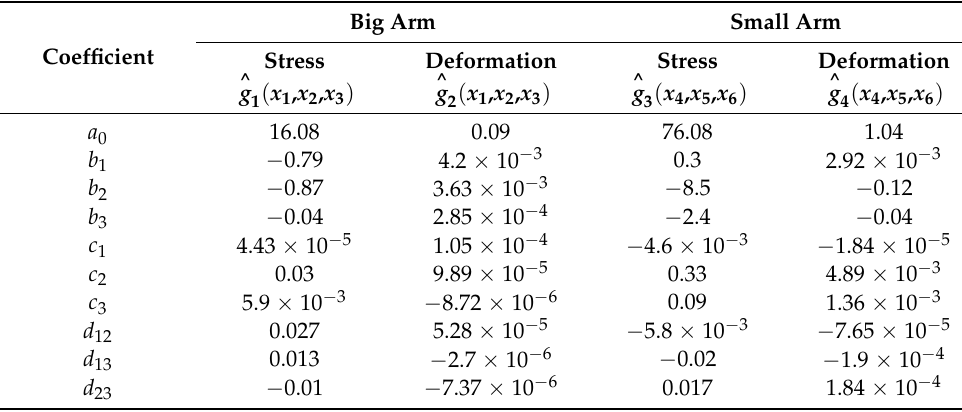
Table 3. Coefficients of the approximation